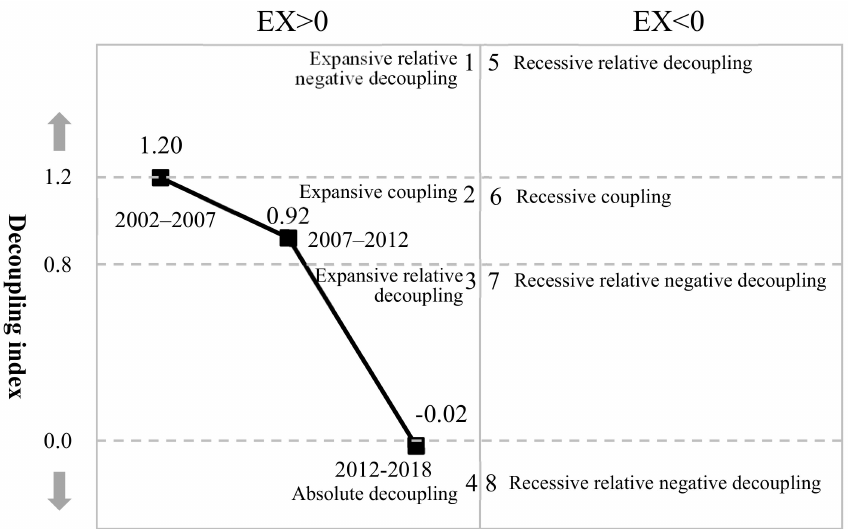
Figure 1. Classification of decoupling between gross exports and embodied energy of export with decoupling